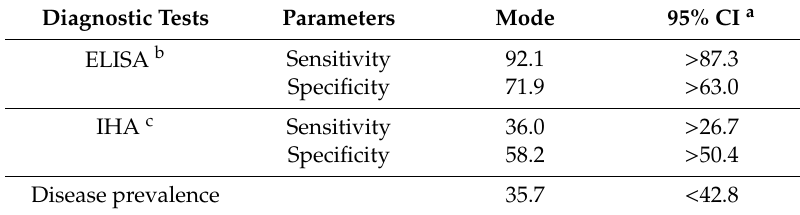
Table 1. Prior estimates for mode and 95% confidence interval (CI) for sensitivity and specificity values of ELISA test and IHA test, and prevalence of the disease